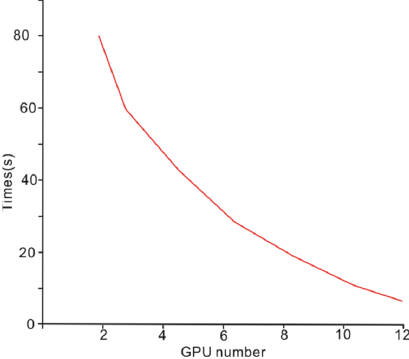
Figure 11. Computation time comparison when use different number of GPUs for the imaging space size is 384 × 384 × 384 and time steps is 16,000.